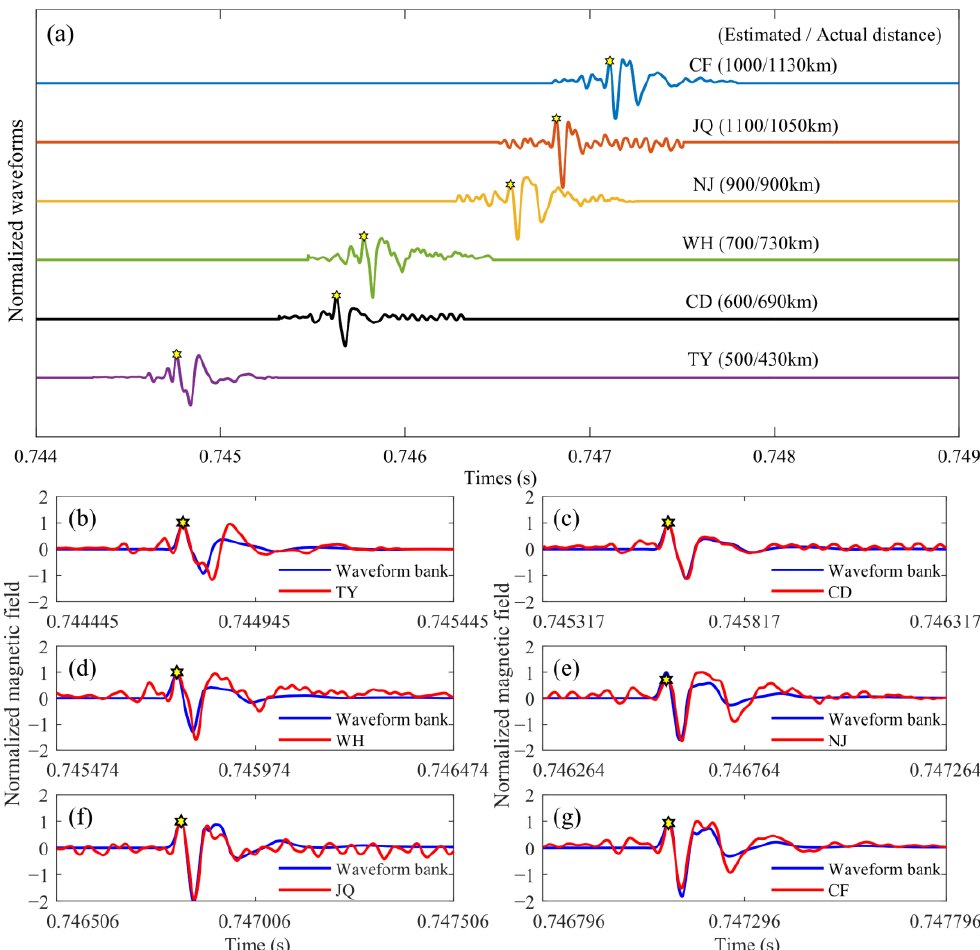
Figure 1. ( a ) Normalized waveforms for a lightning source inside the network at 09:20:37 on 3 October 2021, Beijing time, whose average propagation distance to the sensor is less than 1000 km. The ground wave peak points are marked by yellow hexagrams, and the estimated distance (left) and the actual distance (right) are marked between parentheses. ( b – g ) The recognition result of the ground wave peak point for each measured waveform by the matched waveform bank.